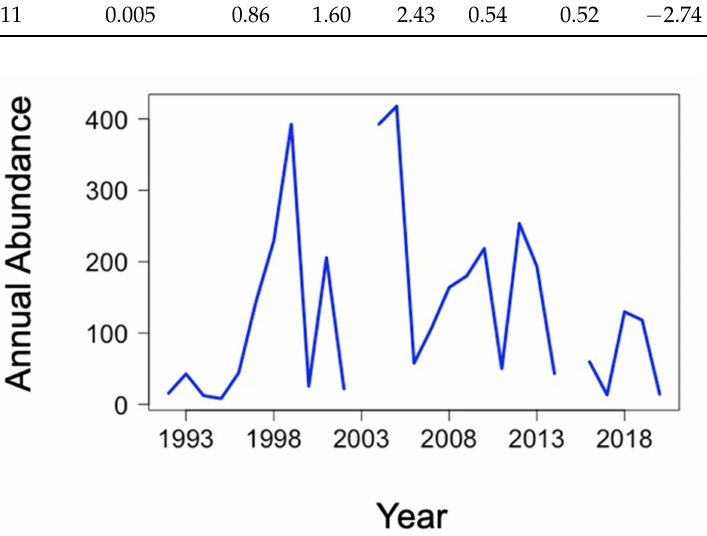
Figure A1. Annual abundance of Calliphora vicina in the eastern Kerguelen Islands over 27-year period